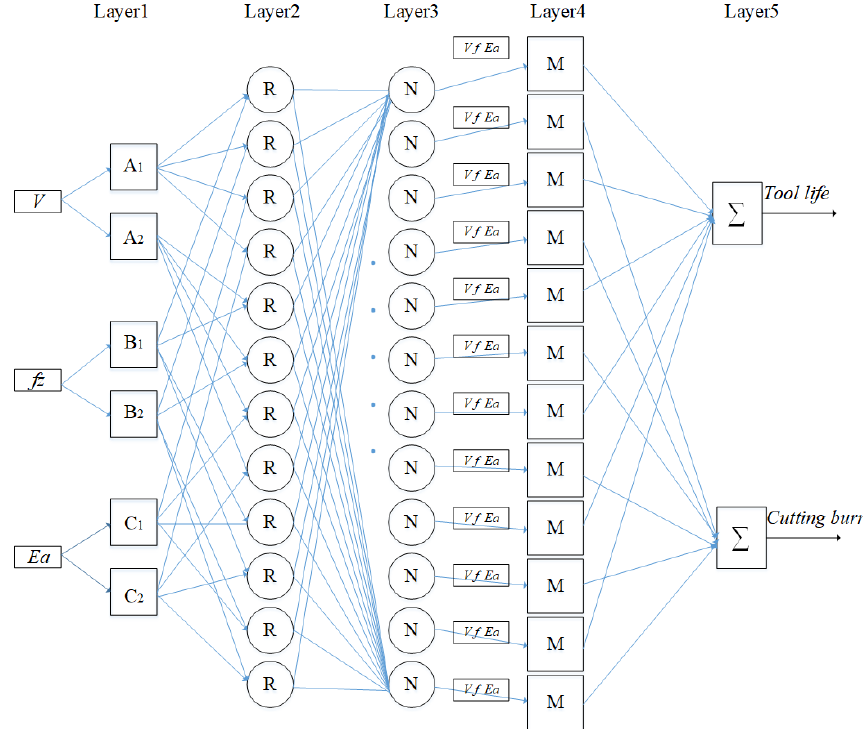
Figure 6. An improved